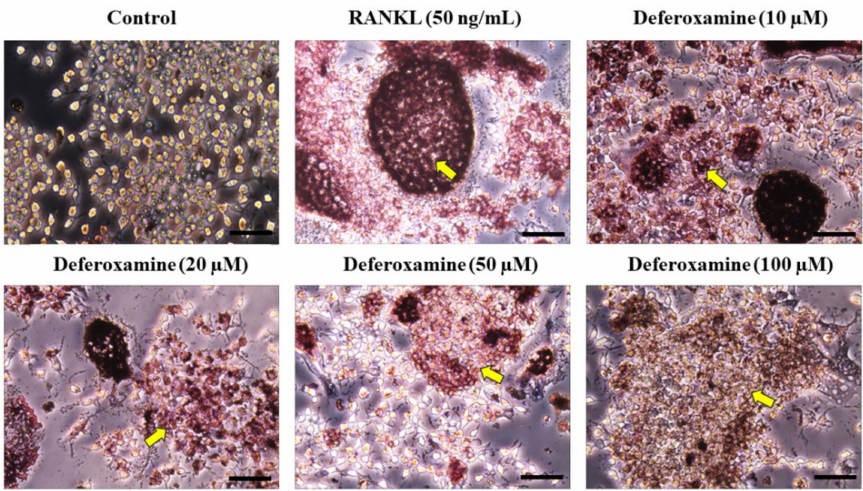
Figure 2. Osteoclast differentiation of DFO in RAW264.7 cells. The cell viability of DFO-treated RAW 264.7 cells was assessed using the CCK-8 assay kit. Tartrate-resistant acid phosphatase (TRAP) staining of DFO in RAW264.7 cells. Cells were applied with different concentrations of DFO for 2 h followed by treatment with 50 ng/mL receptor activator of nuclear factor- κ B ligand (RANKL) for 3 days. Subsequently, RAW264.7 cells were fixed and stained to detect TRAP. The osteoclasts were stained red (yellow arrow). Scale bars = 50 µ